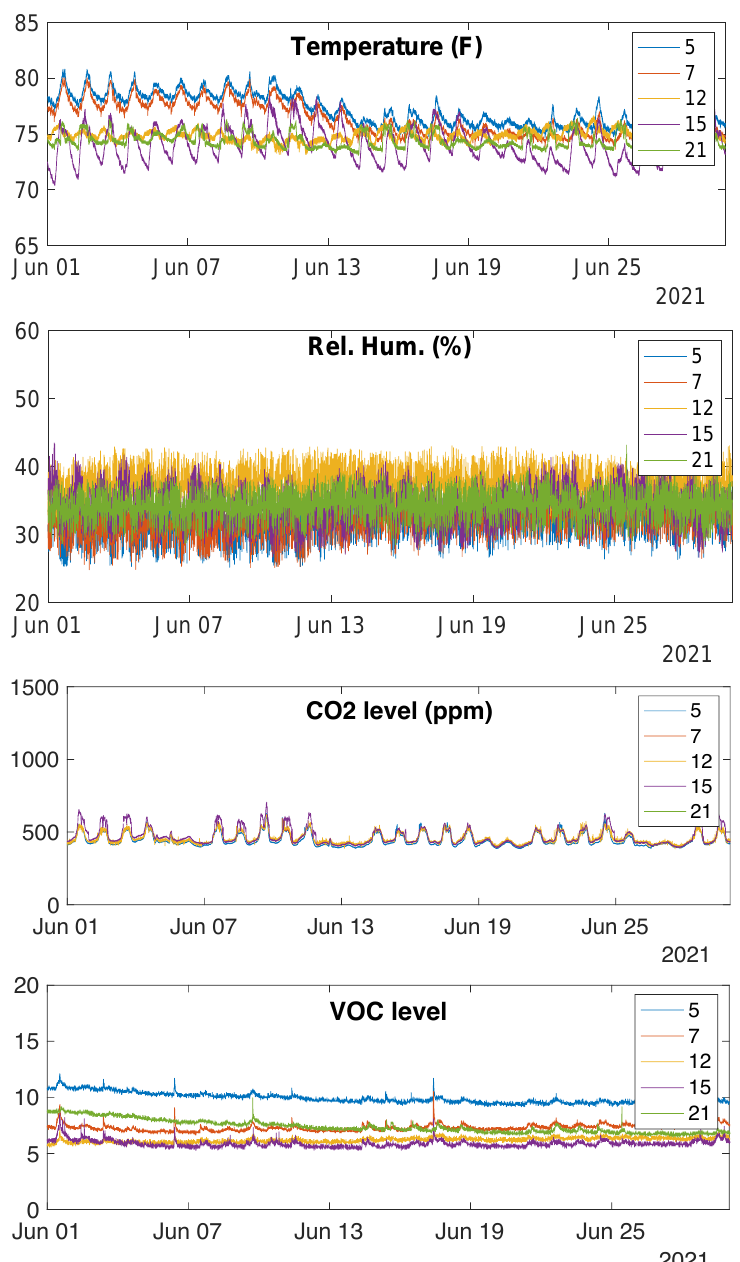
Figure 7. Data on four environmental variables collected by sensors in the PCFNs deployed in the iHub. Legends correspond to UIDs of